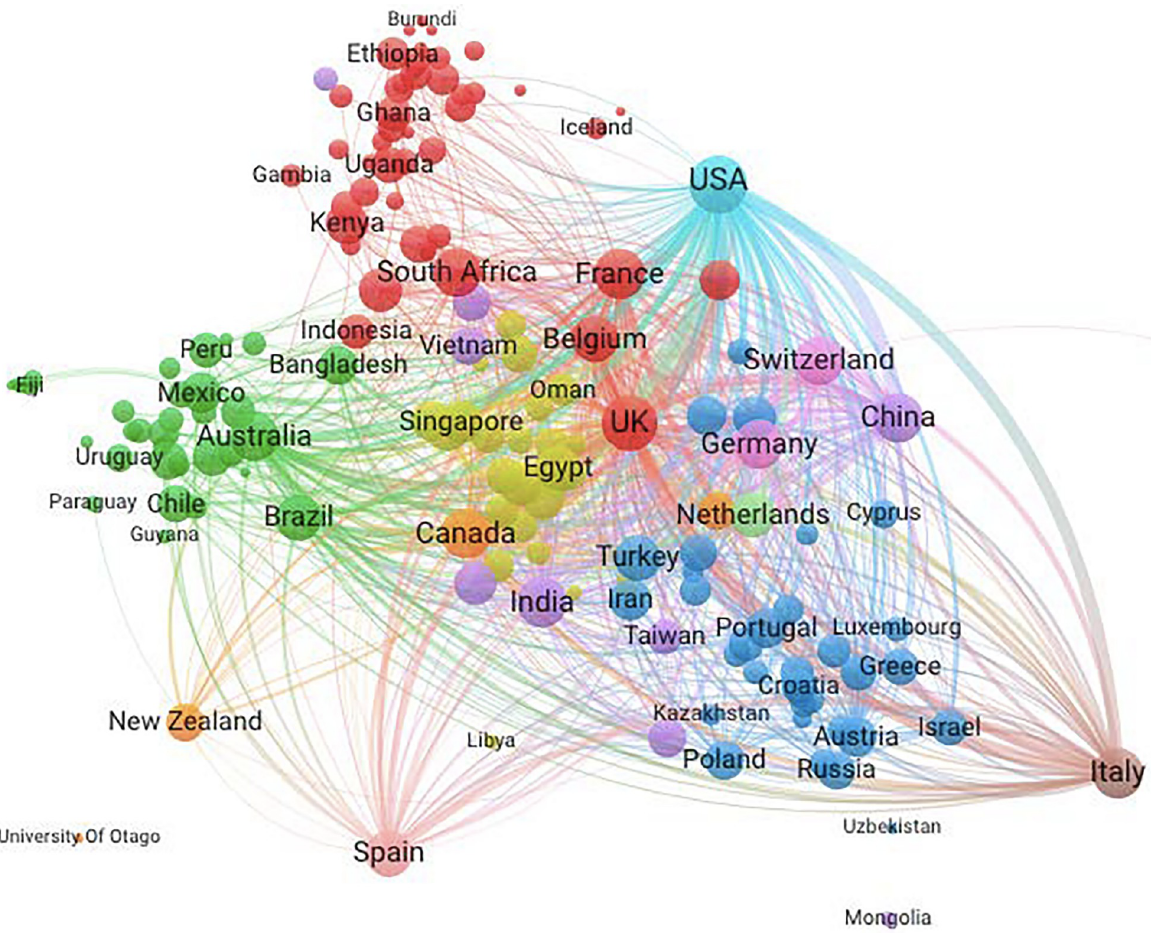
Fig 9. COVID-19 international collaboration network in coronavirus research, 2020. Interactive version accessible at https://app.vosviewer. com/?json=https://drive.google.com/uc?id=1TLdcW-lNUQ1k0kDlpZYOUQL57E8MKNqM.